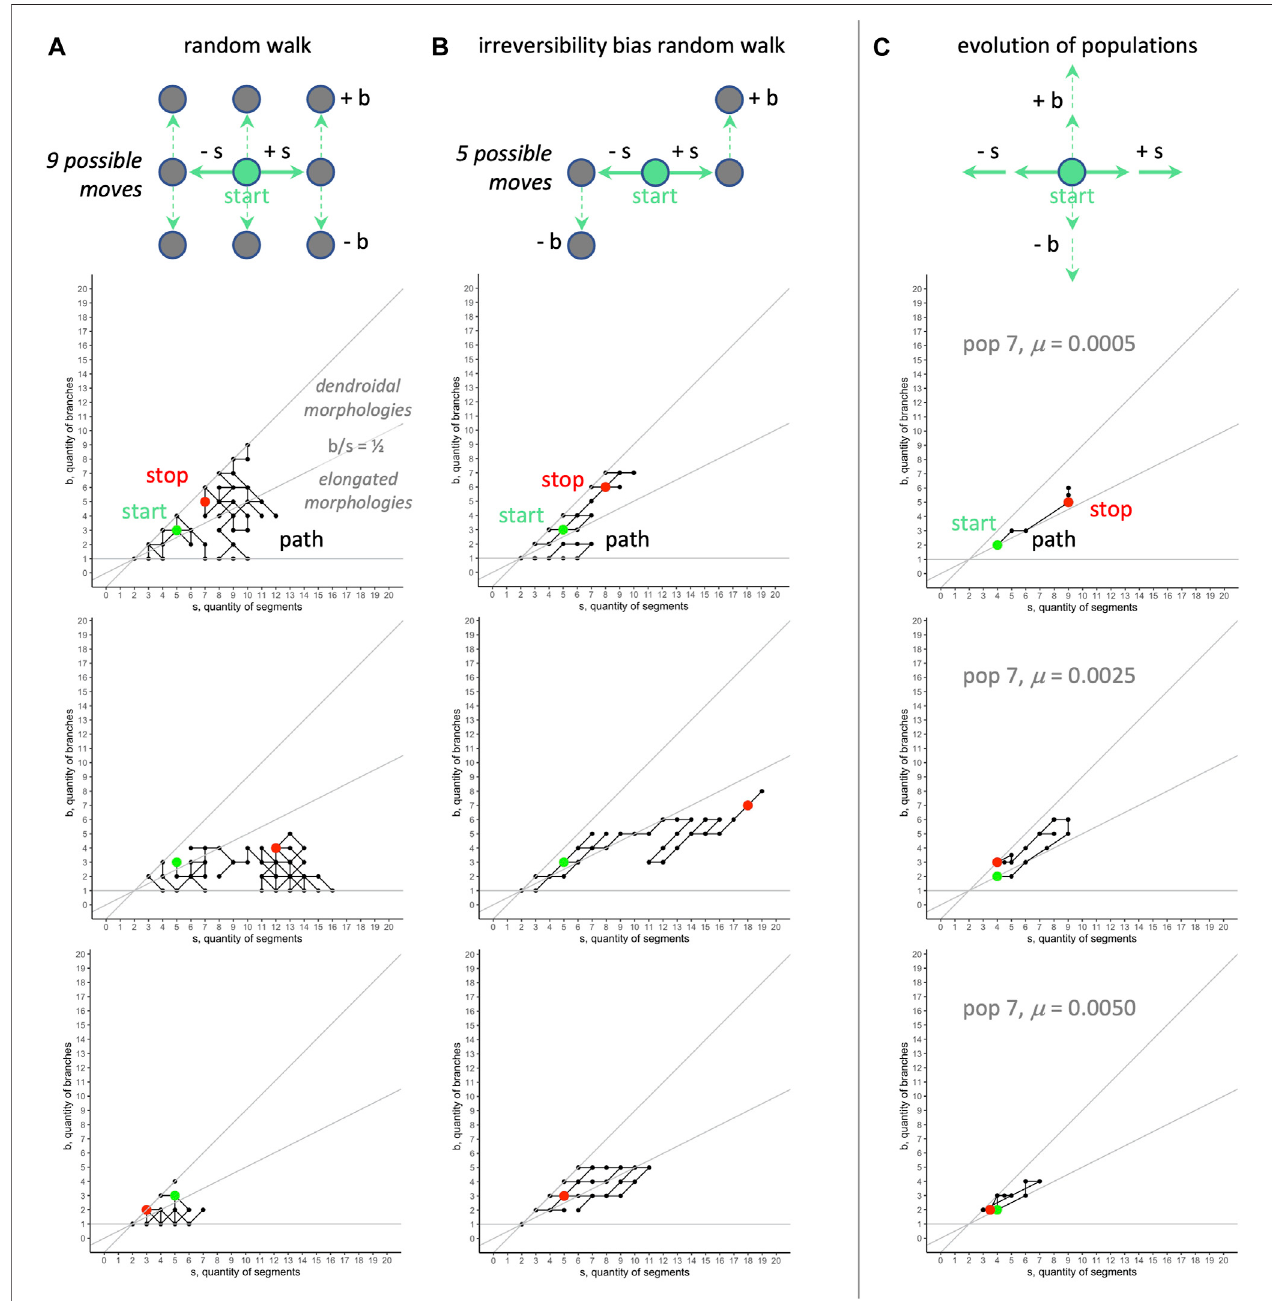
FIGURE 11 | Random morphospace walk analysis: examples. Random walks (A) can move in any direction, and move into dendroidal and elongated sections of morphospace in thesethree examples. The irreversibility bias (B) , representing apossible developmental bias, causes the random walk to move diagonally with positive slope. For comparison, the evolutionary trajectories of three populations (C) tend to occur in the dendroidal morphologies section of the morphospace (for aggregate view, see Figure 10 ). The same random seed is used for the row-wise comparisons in the random walks. The random models start with the mean value of morphology evolved over all generations, s (cid:1) 5 and b (cid:1)